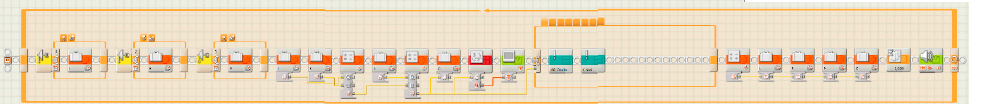
Figure 4. Random mouse algorithm implementation in the Lego Mindstorms NXT visual programming environment.